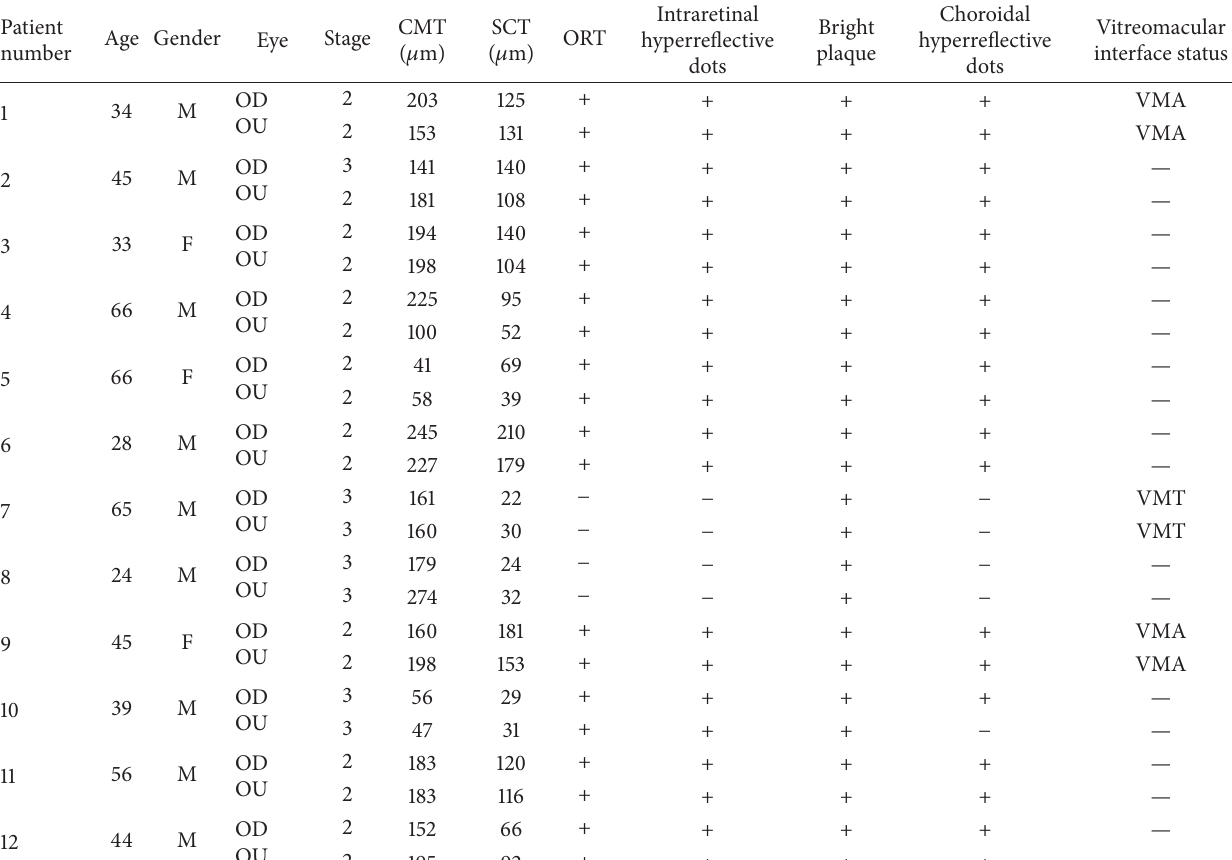
Table 1: Patients’ characteristics and OCT